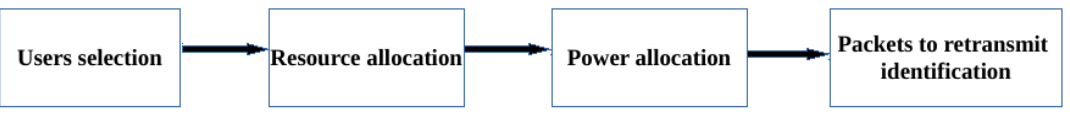
Figure 1. Flowchart of the proposed ICIC